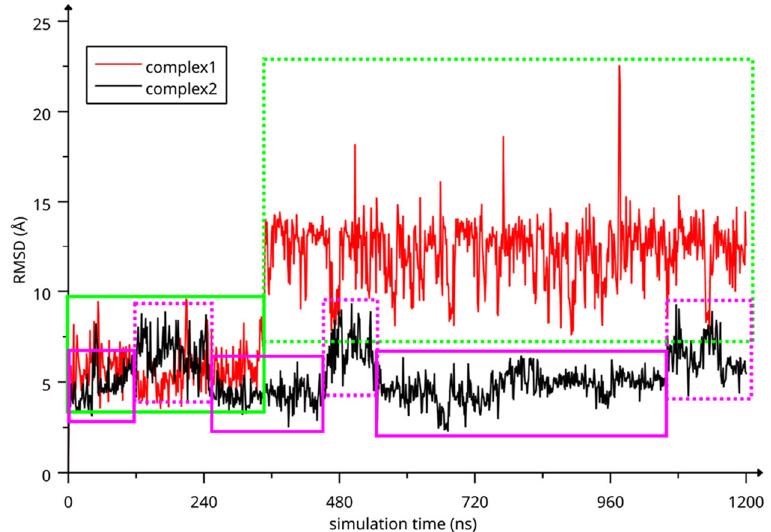
Figure 7. RMSD values of IDE atoms as a function of simulation time. The highlighted regions represent: IDE included in ACyD8 cavity (complex1—green solid line), IDE randomly interacting with the outer part of ACyD8 (complex1—green dashed line), cluster 1 of complex2 MD conformations (magenta solid lines) and cluster 2 of complex2 MD conformations (magenta dashed lines).